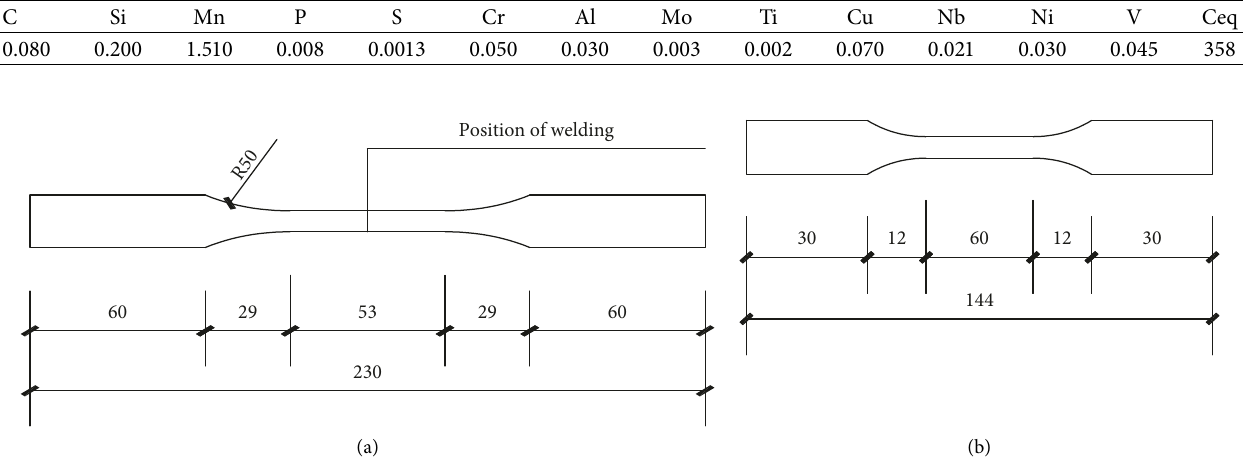
Figure 2: Specimen design (Units: mm). (a) Sheet material specimen. (b) Rod-shaped specimen. Table 2: Welding parameters of Q460 submerged arc welding. Welding